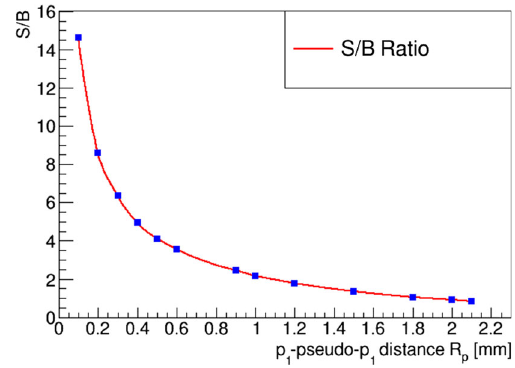
Fig. 10 The signal to background ratio for d tot = 0 . 5 + 10 · σ and R p = 0 . 5 mm for the LHC working with β ∗ = 90 m